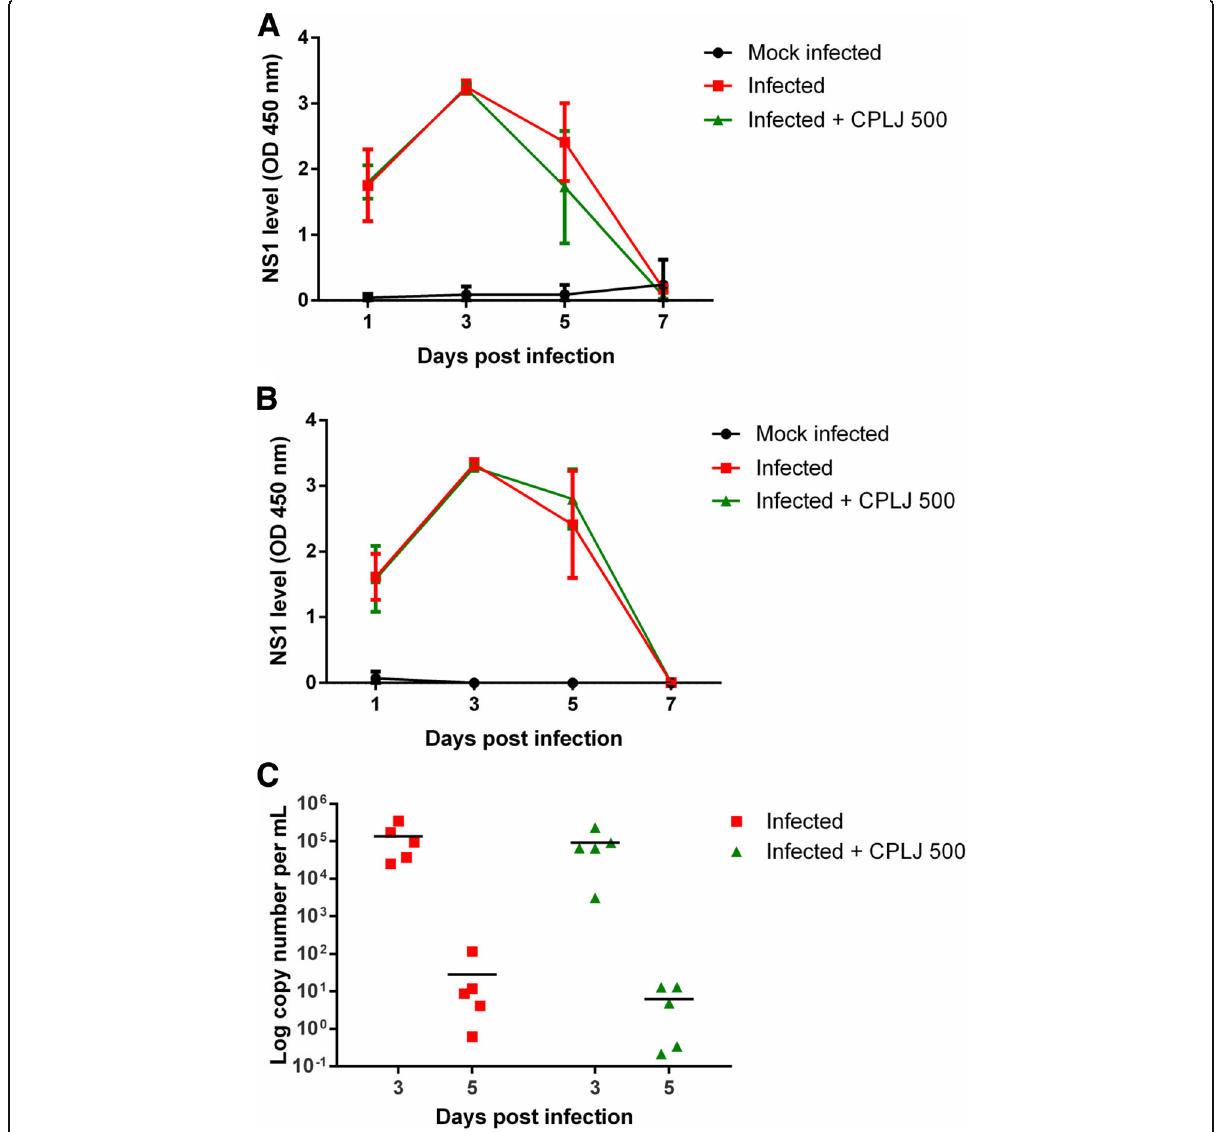
Fig. 3 The effect of freeze-dried CPLJ on the level of NS1 and viral RNA. AG129 mice inoculated with ( a ) 2X10 5 PFU and ( b ) 2X10 6 PFU dengue virus strain NGC were treated with 500 mg/kg BW of freeze-dried CPLJ once a day from day 1 to day 3 post infection. The NS1 levels in plasma of mock infected (black circles) ( n =5), infected (red squares) ( n =5) and infected+CPLJ 500 (green triangles) ( n =5) AG129 mice groups were detected on day 1, 3 and 5 by NS1 antigen immunoassay. ( c ) The plasma viral RNA of infected (red squares) ( n =5) and infected+CPLJ 500 (green triangles) ( n =5) AG129 mice groups (2X10 6 PFU) were detected by quantitative reverse transcription PCR on day 3 and day 5 post infections. Data represent mean values ± standard deviations